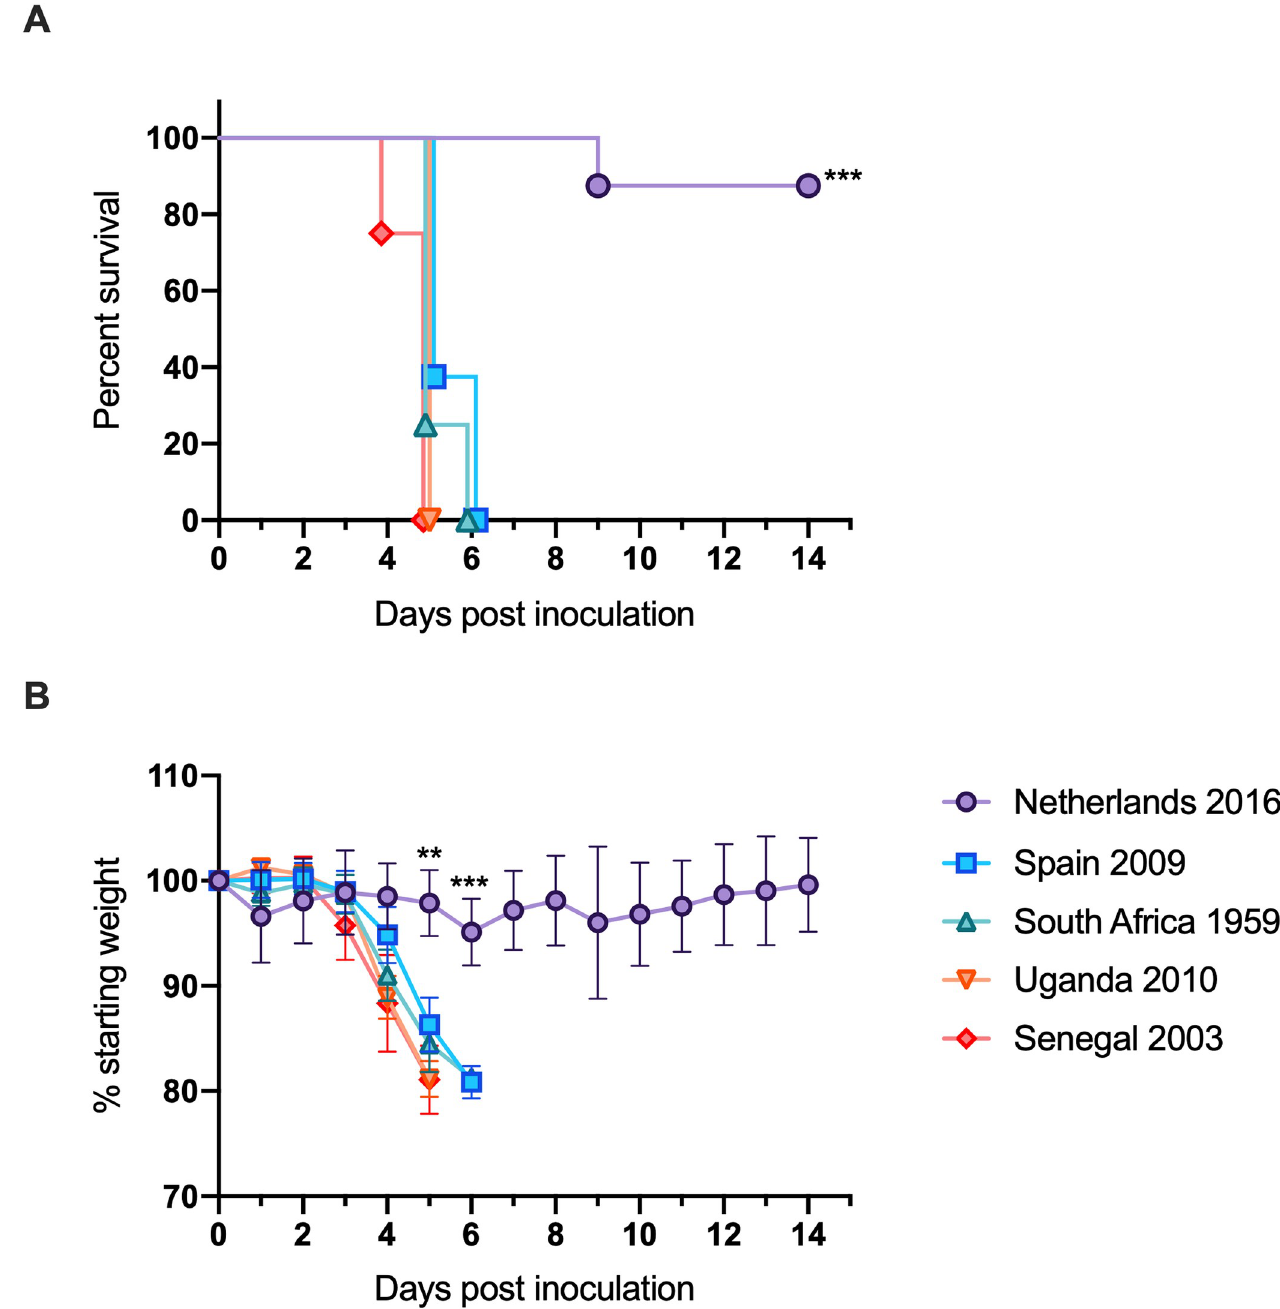
Fig 2. Morbidity and mortality of mice inoculated with USUV isolates. (A) Percent survival of mice post-inoculation. (B) Average percentage of initial weight post-inoculation. �� p < 0.01, ��� p < 0.001. Sections from liver were also affected in these animals. Livers of all animals were semi- quantitatively evaluated for inflammation and cell death and summed for a total pathology score. Animals infected with the Spain 2009, Senegal 2003, Uganda 2010, and South Africa 1959 strains of Usutu virus generally had higher amounts of inflammation and necrosis in the liver than those infected with the Netherlands 2016 strain (Fig 4B). Inflammation when